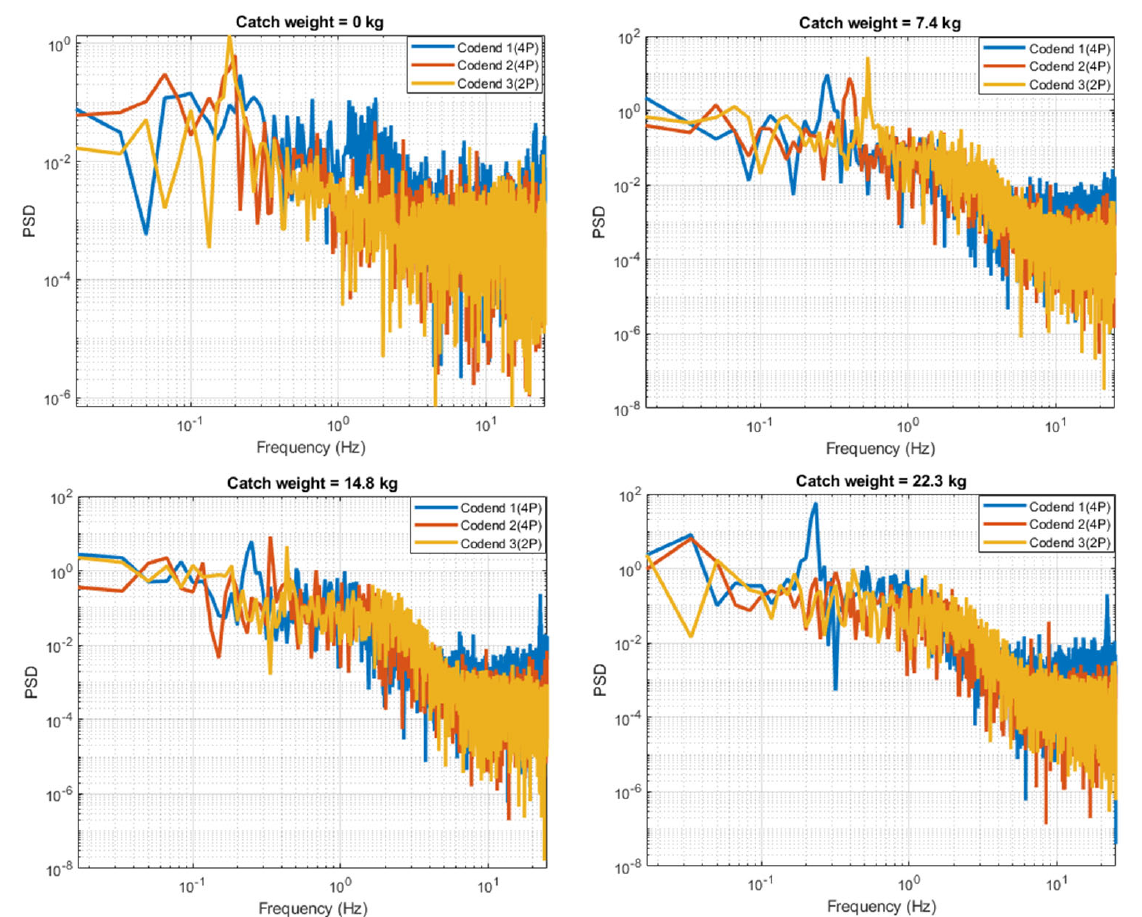
Figure 6. PSD representation (in a log–log scale) of the codend drag force at different catch weights.